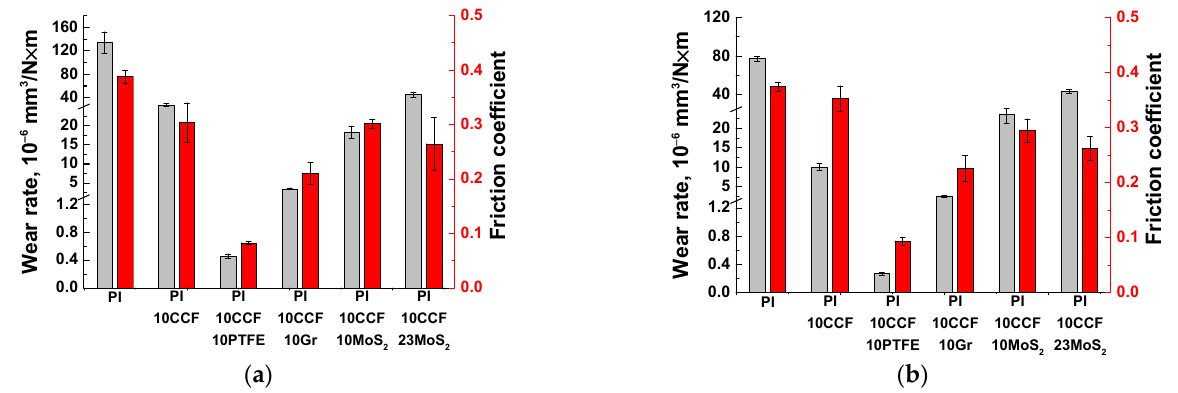
Figure 4. Wear rates and the friction coefficients for neat PI (1), as well as the PI/10CCF, PI/10CCF/10PTFE, PI/10CCF/10Gr, PI/10CCF/10MoS 2 , and PI/10CCF/23MoS 2 composites. Metal ( a ) and ceramic ( b ) counterparts. The ‘pin-on-disk’ scheme.